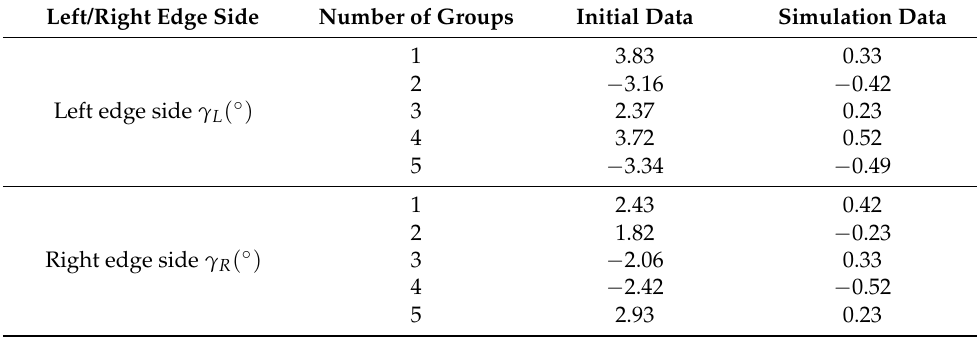
Table 3. Experimental data of scroll angle of ESR.